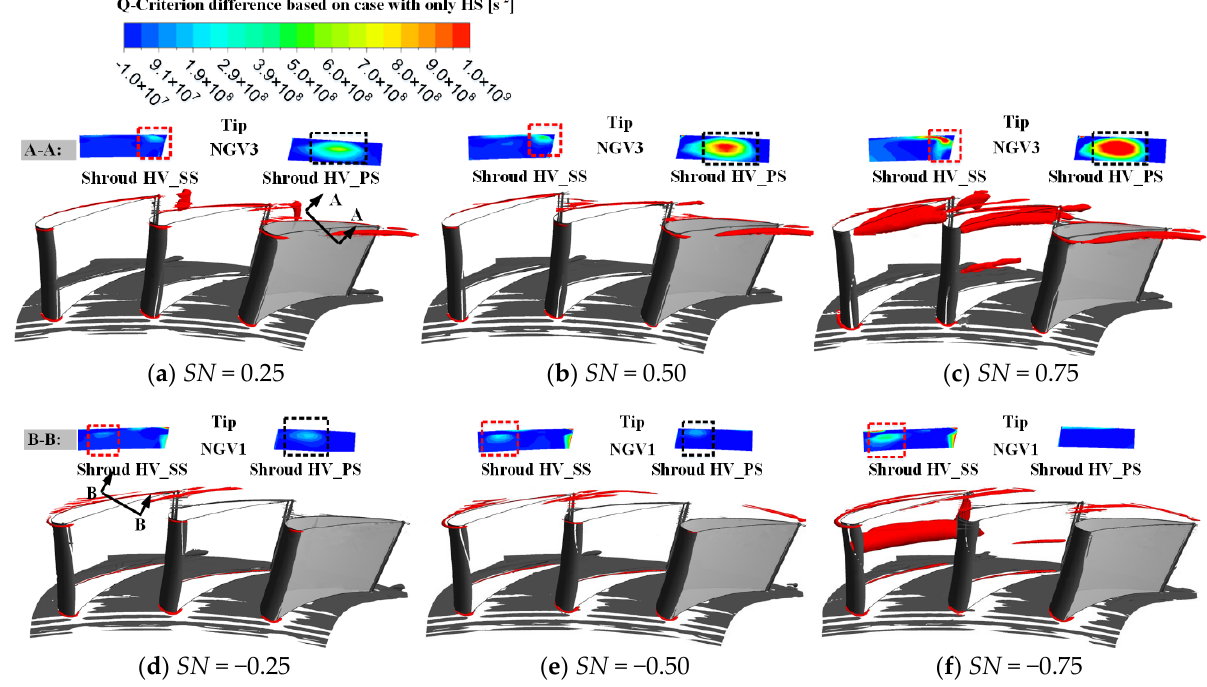
Figure 17. Vortex structures of the swirl cases (iso-surface of Q-criterion, Q=1.5×10 8 s − 2 ). The induced secondary flows inevitably cause additional aerodynamic losses. The losses were evaluated using the total pressure loss coefficient, CP loss , which is defined by Equation (3) where the P t,inlet and P t,outlet are the total pressure at inlet and outlet, individually. As expected, the no-swirl case has the minimum aerodynamic losses of 4.23% and the CP loss are seen to raise with the swirl intensity, as shown by Figure 18. At the low and medium swirl intensities, the positive swirl cases have little smaller aerodynamic losses than these at negative swirl, however, at high swirl (| SN | = 0.75), the opposite is true. This may be due to the fact that in comparison with case at SN = − 0.75, one additional vortex appears near NGV2 SS at SN =0.75. Thus, the strong positive swirl generates the maximum aerodynamic losses, which is around 10% higher relative to the no-swirl case.